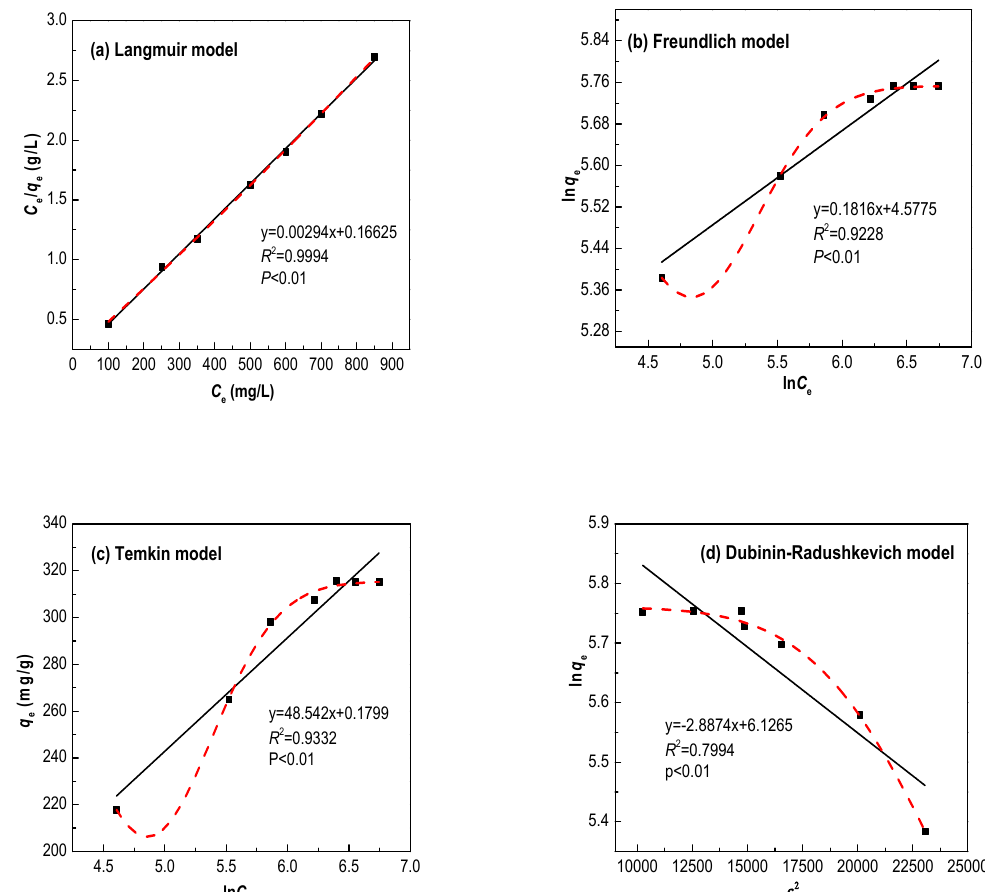
Figure 7. ( a ) Langmuir, ( b ) Freundlich, ( c ) Temkin, and ( d ) Dubinin–Radushkevich isotherm models for adsorption of Zn(II) by the Ln@AC nanocomposite. Table 4. The q max values for the adsorption of Zn(II) on di ff erent Table 3. The R 2 and constant values for the adsorption isotherm models of Zn(II). Adsorption